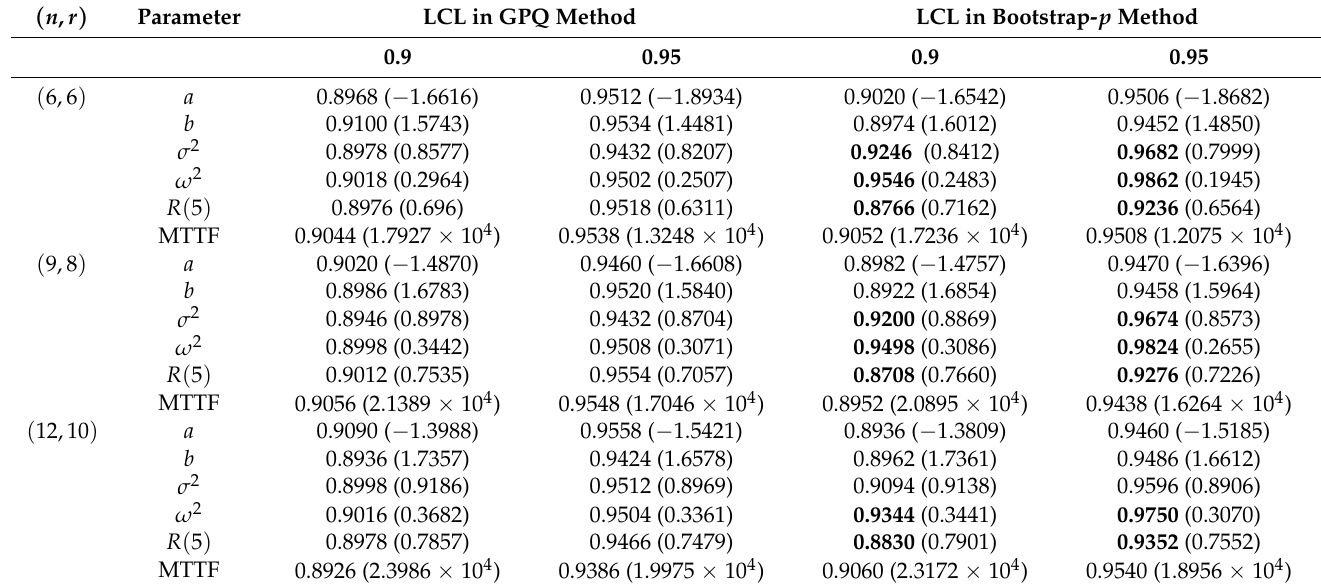
Table 5. The CPs and average values (in parentheses) of different LCLs for model parameters and some quantities under parameter setting I for nominal levels 0.9, 0.95, based on 5000 replications.